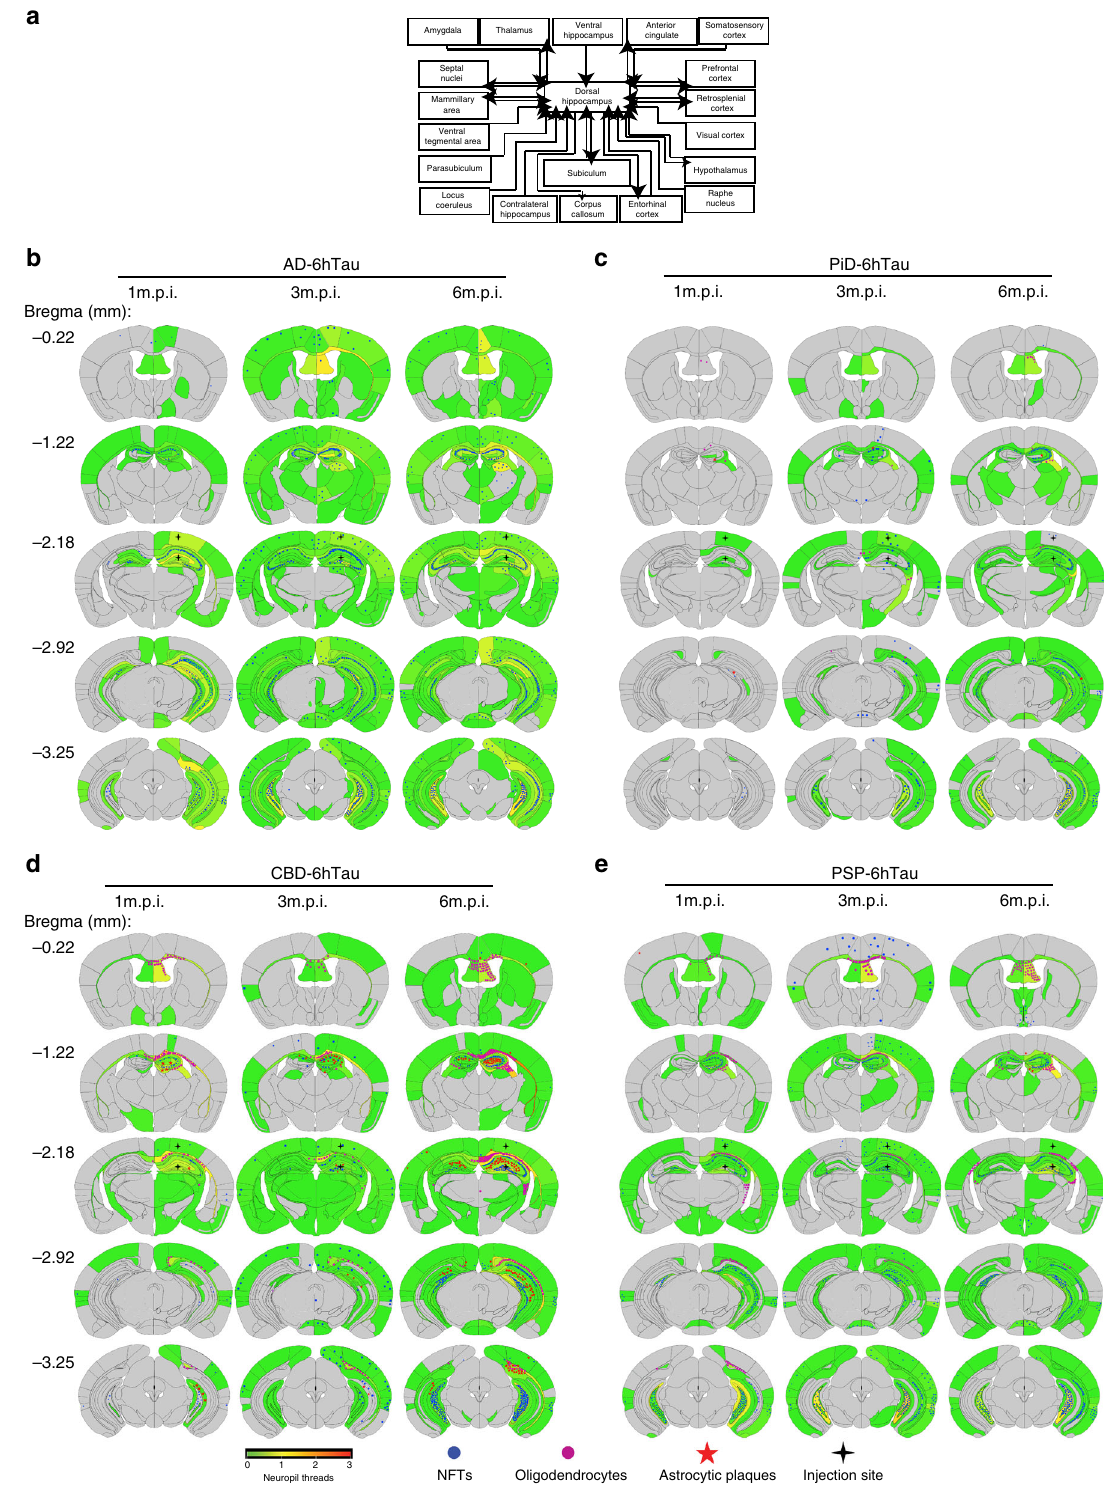
Fig. 5 Distribution of induced tau pathologies in 6hTau mice. a Neuroanatomic connectome map showing the anterograde and retrograde connections between the injection site (dorsal hippocampus) and other major brain regions. The distribution of the induced tau aggregates in 6hTau mice by different b AD; c PiD; d CBD, and e PSP tau strains were mapped and shown in fi ve representative coronal brain sections at Bregma levels mm: − 0.22, − 1.22, − 2.18, − 2.92, − 3.25. Neuropil threads were indicated using the heatmap, with gray color indicating no and red color indicating abundant neuropil threads. Neuronal tau pathologies are marked by blue dots, astrocytic tau pathologies are shown as red stars and oligodendrocyte tau pathologies are marked by purple dots. The density of the dots re fl ects the relative abundance of these tau pathologies. Injection sites are marked with black stars. Mice were examined at 1, 3, and 6 m.p.i., and each group contained 3 – 6